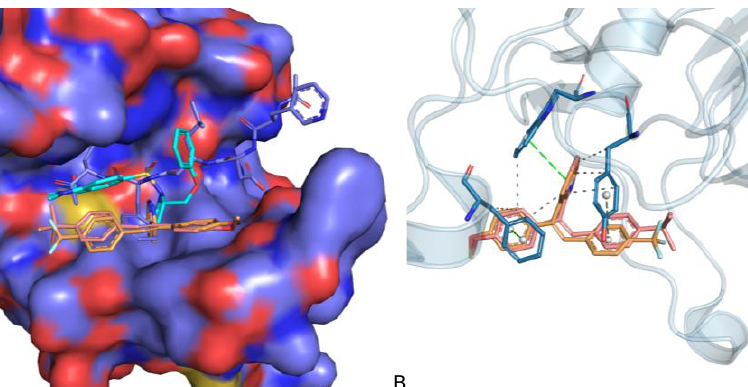
Figure 13. Predicted binding modes of compounds 10a (in salmon) and 12a (in orange) in the caspase-3 binding site (PDB ID: 6CKZ, 1GFW) ( A ) in comparison with the 6CKZ co-crystallized ligand (in blue) and the 1GFW co-crystallized ligand (in cyan) and ( B ) with detailed information about the interactions established between our compounds and the caspase-3 binding site obtained using PLIP [53] (green dotted lines: π - stacking; grey dotted lines: hydrophobic).